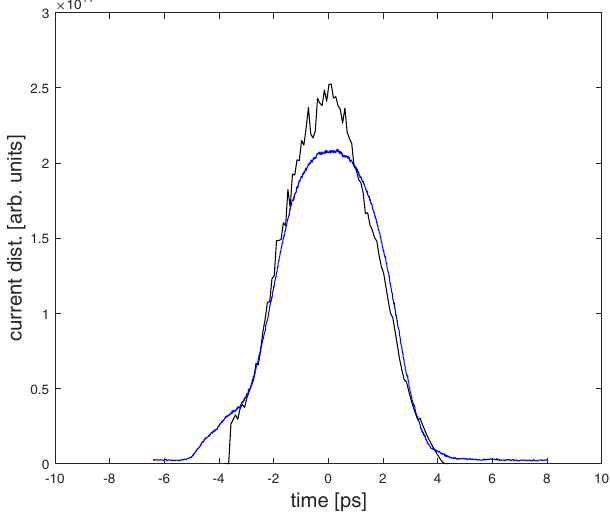
FIG. 9. Longitudinal current profiles I ð τ Þ are measured either by the dechirper (black line) or by the TCAV (blue line). The measured FWHMs are 3 . 895 (cid:3) 0 . 058 ps (black line) and 4 . 265 (cid:3) 0 . 021 ps (blue line), respectively. The negative time ( τ < 0 ) corresponds to the front part of the